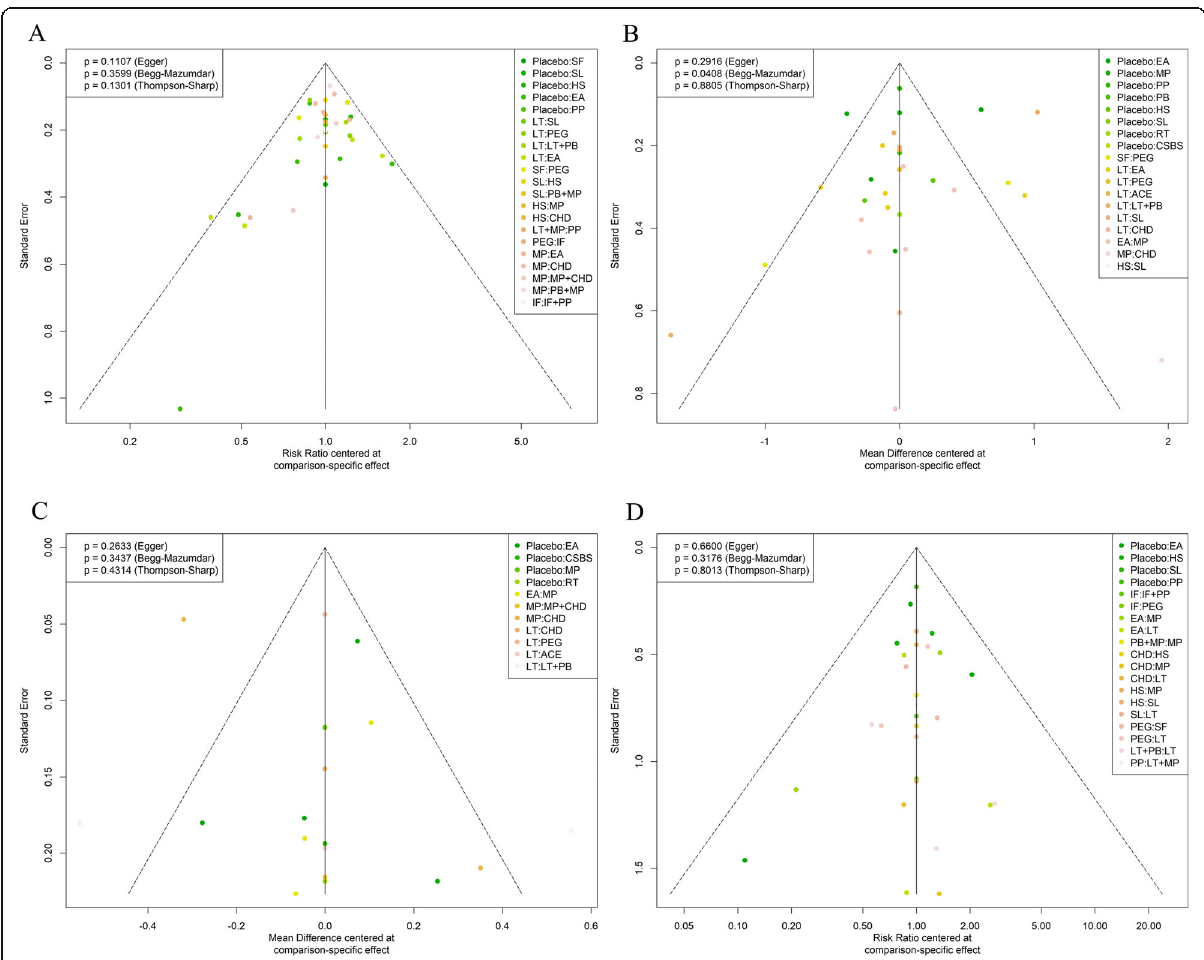
Fig. 7 Funnel plot. a The risk ratio of the responder rate. b The mean difference of the SBM count. c The mean difference of the BS. d The risk ratio of adverse